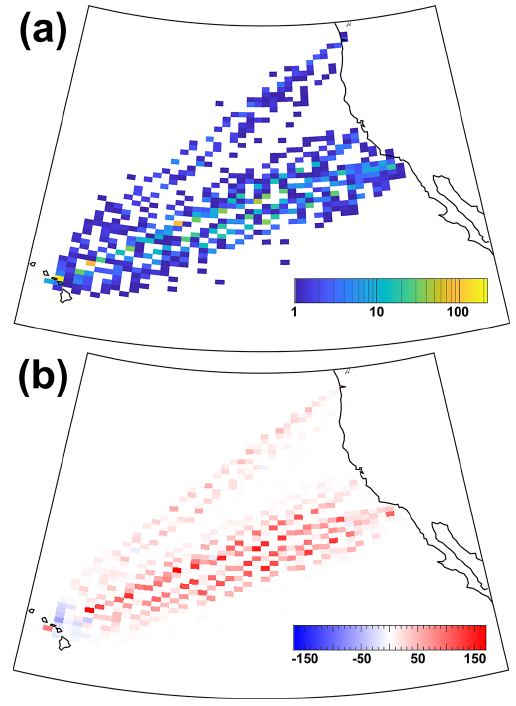
Figure 3. Occurrence rate of (a) intercept points between aircraft flight tracks, from Honolulu to Los Angeles, San Francisco, and Seattle for the years 2010 and 2011, and the ground track of the CALIPSO satellite for all-sky conditions, as identified using Track- Matcher for a time difference of ± 2 . 5h, and (b) absolute difference in the occurrence rate of intercepts in panel (a) compared to those used by Tesche et al. (2016). The red colour marks an increase in the number of identified intercepts using TrackMatcher compared to the data set of Tesche et al. (2016).